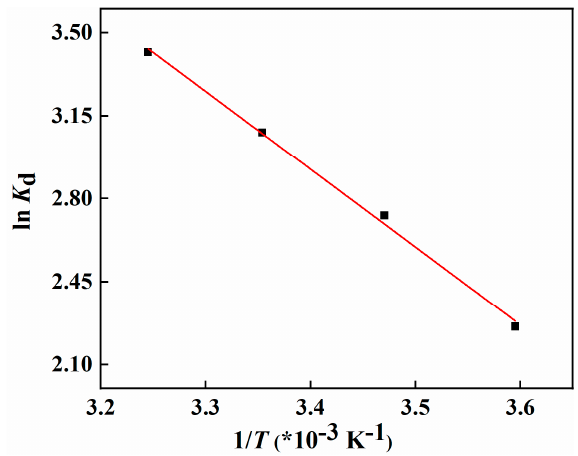
Figure 10. Fitted curves of ln K d and 1 / T (* 10 –3 · K − 1 ) by using the Van’t Ho ff